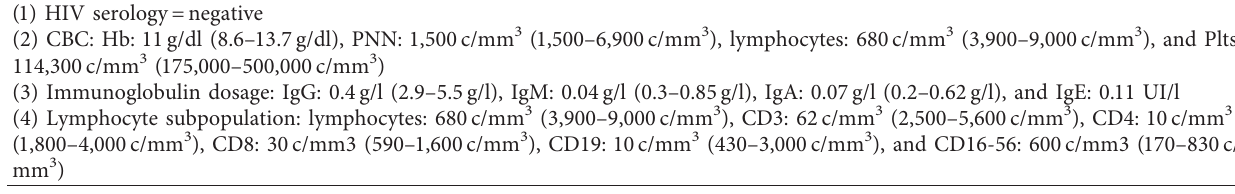
Table 2: Immunological workup.